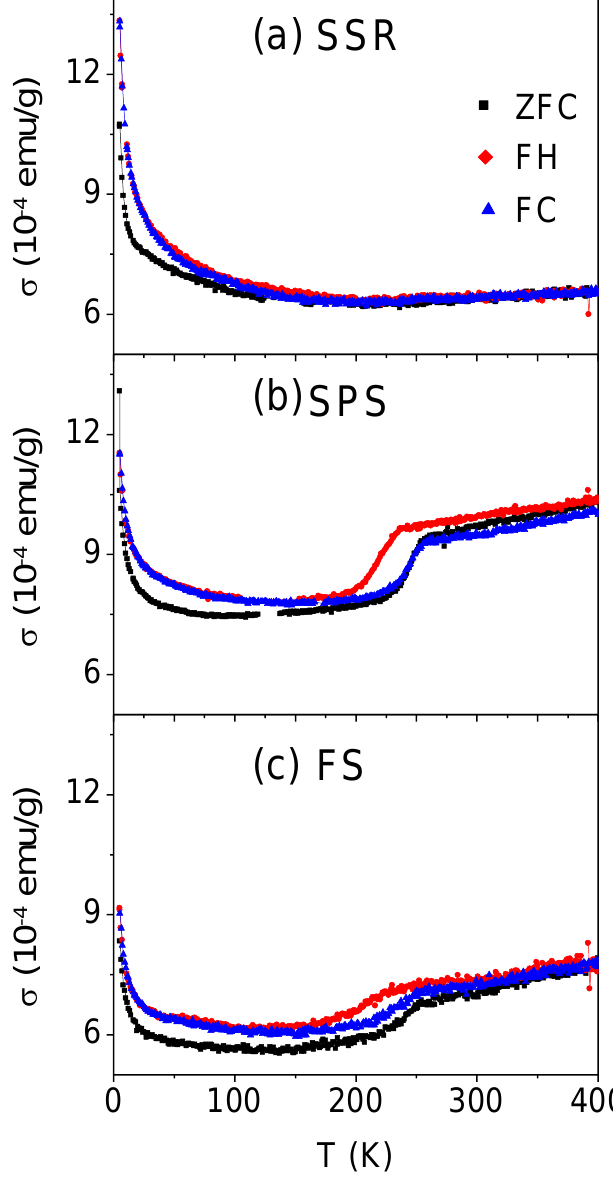
Figure 4. Temperature dependence of the magnetization of the specimens prepared by ( a ) SSR, and mechanosynthesis and sintered by ( b ) SPS and ( c ) FS, depicting ZFC, FH, FC curves, with an external applied magnetic field of 100 Oe.